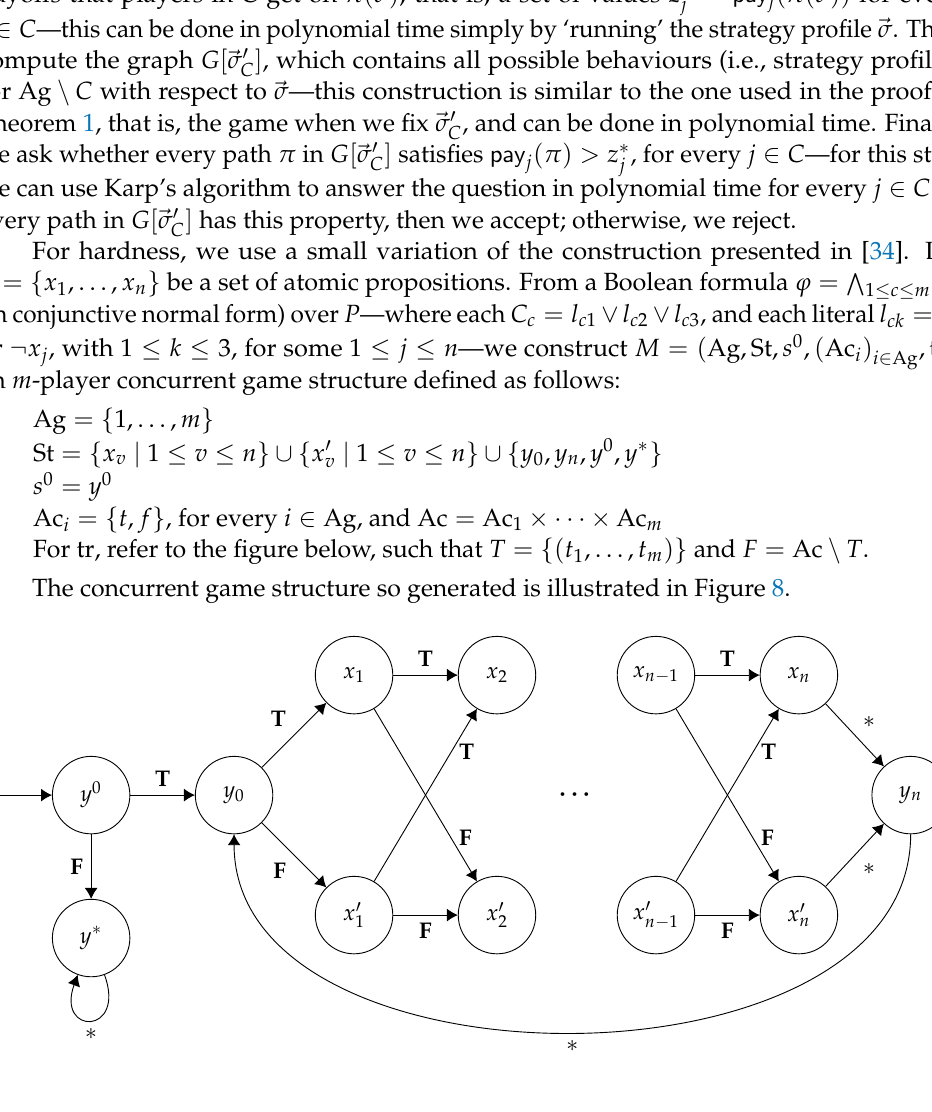
Figure 8. Concurrent game structure for the reduction from 3SAT. The asterisks * are wildcards—they match any action which isn’t explicitly detailed on the